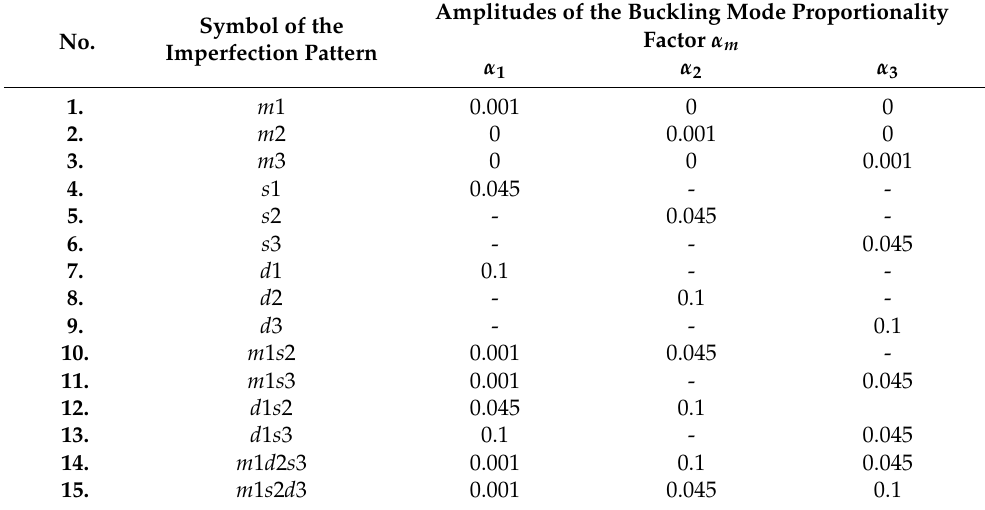
Table 1. Description of numerical